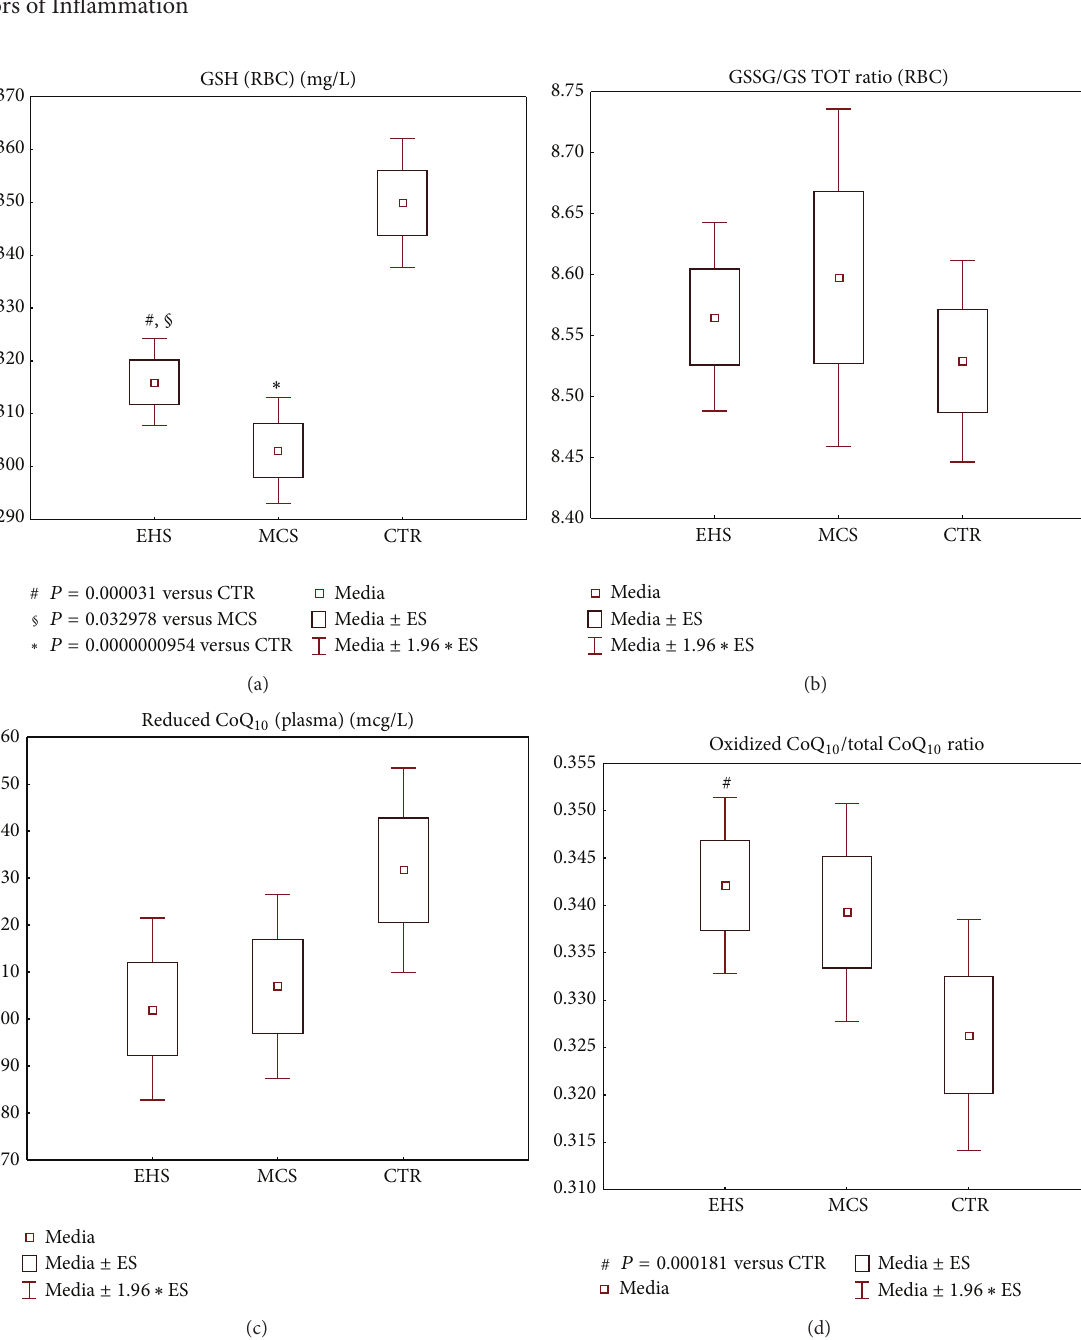
patient subgroups compared to controls, differences were unable to reach any statistical significance (data not